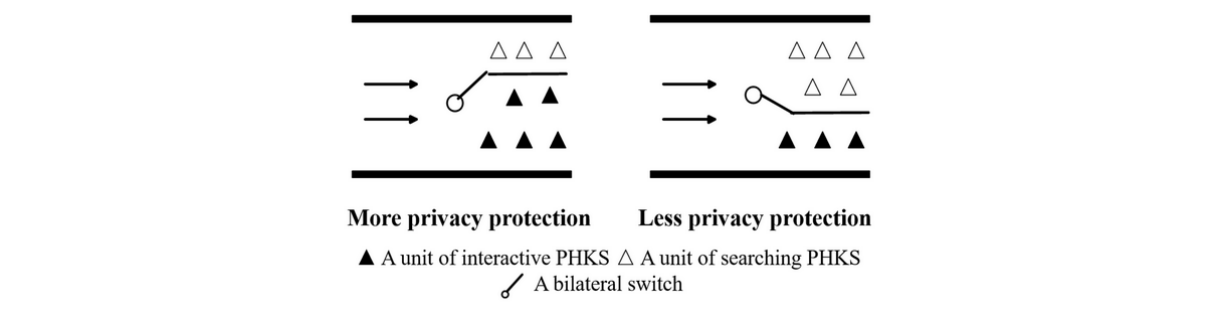
Figure 1. Illustration of the effect of privacy protection settings on interactive and searching professional health care knowledge sharing. PHKS: professional health care knowledge sharing.